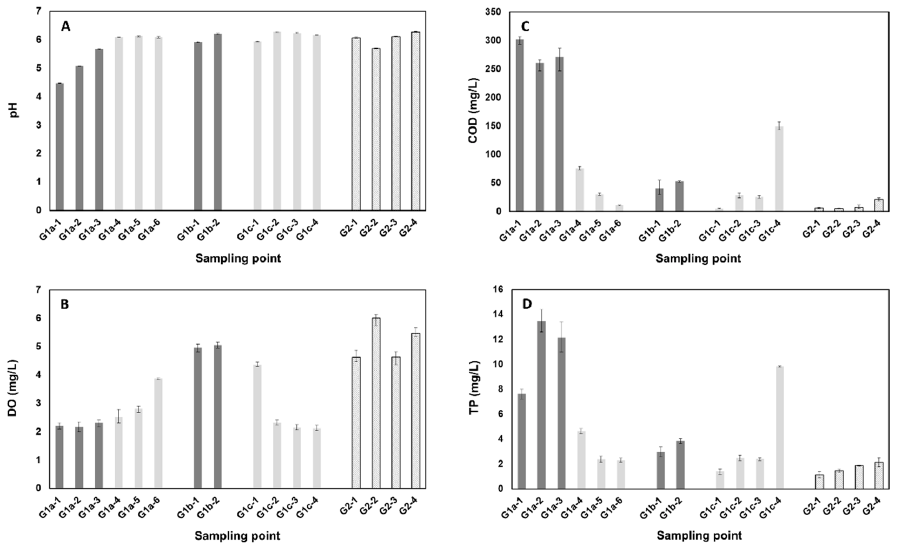
Figure 5. Changes in water quality indexes: ( A ) pH; ( B ) DO: Dissolved oxygen; ( C ) COD: Chemical oxygen demand; and ( D ) TP: Total phosphorus in the Galing River.